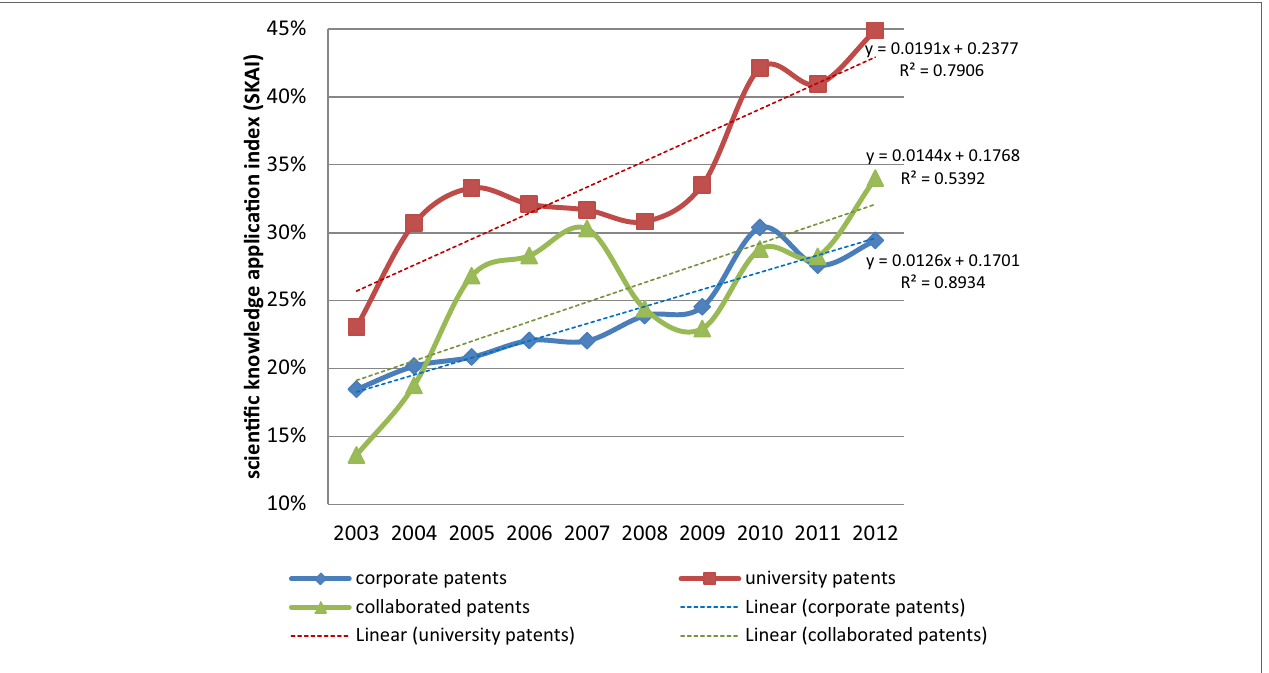
FigUre 2 | Scientific knowledge application index (SKAI) by year. Note: See Eq. 1 for the calculation of this